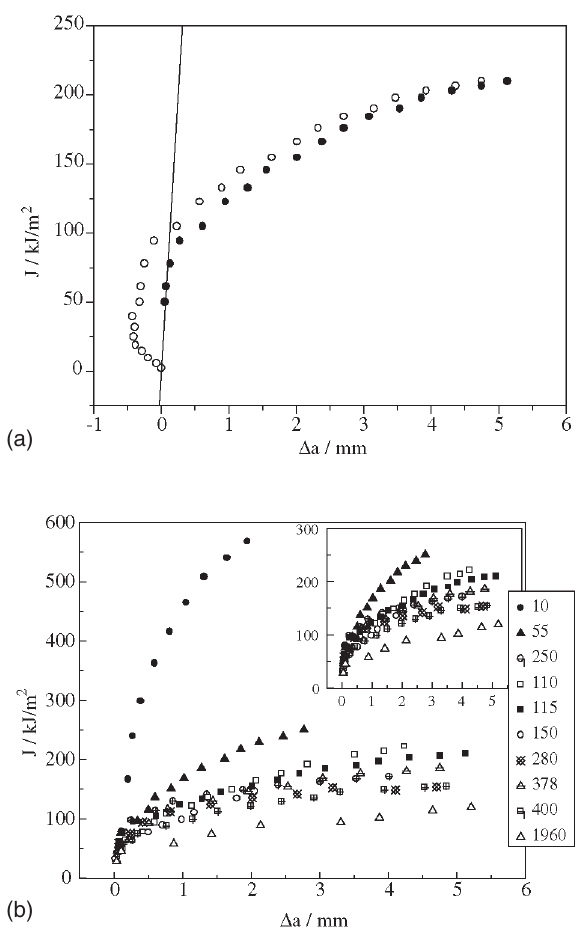
Figure 2. Load – load line displacement records obtained in speci- mens with different hydrogen contents.